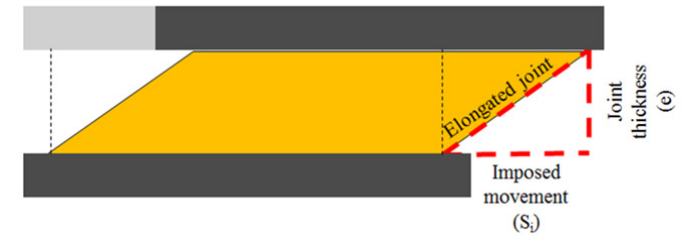
Fig. 8 Shear deformation of the